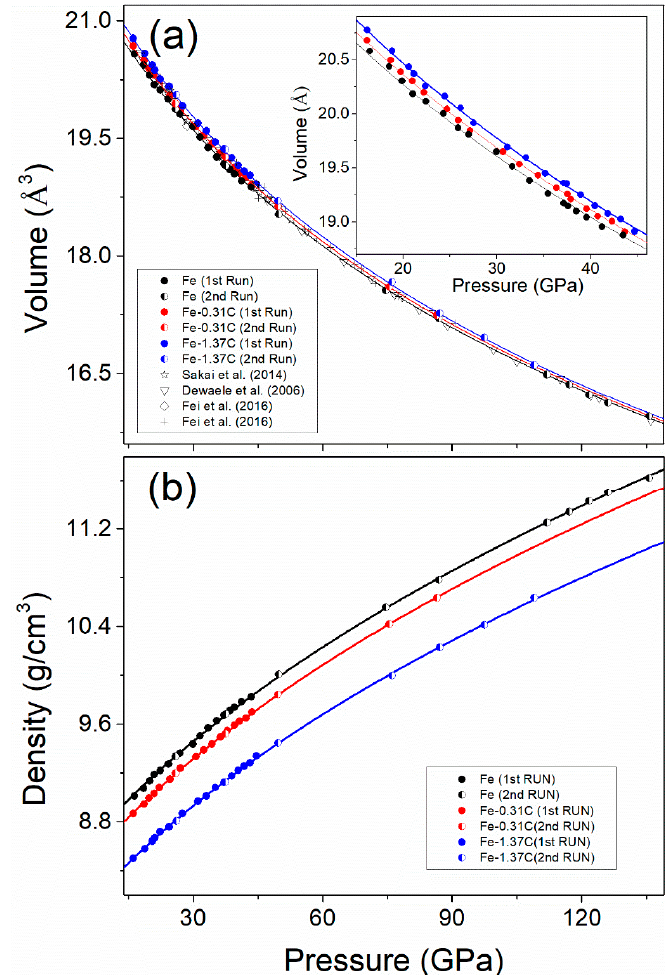
Figure 2. Compression curves for Fe-C samples. ( a ) Pressure and volume relation ( P–V ) of hcp-Fe with 0, 0.31 and 1.37 wt % of carbon; ( b ) pressure and density relation ( P – ρ ) of hcp-Fe with 0, 0.31 and 1.37 wt % of carbon. Au was used as the pressure calibrant below 15 GPa, while neon peaks were used as the pressure calibrant above 15 GPa. Solid symbols represent data from the 1st RUN and half-open symbols represent data from the 2nd RUN; the P – V and P – ρ relations were fitted using a third-order Birch–Murnaghan equation of state using combined data from 1st and 2nd RUN; black, red and blue curves are for Fe-0C, Fe-0.31C and Fe-1.37C,